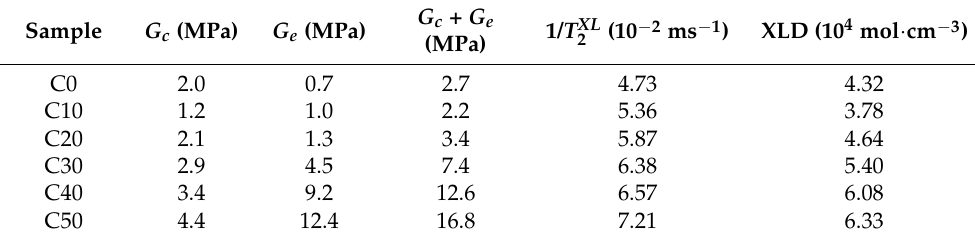
Table 3. Parameters of network in CSDPF/NR